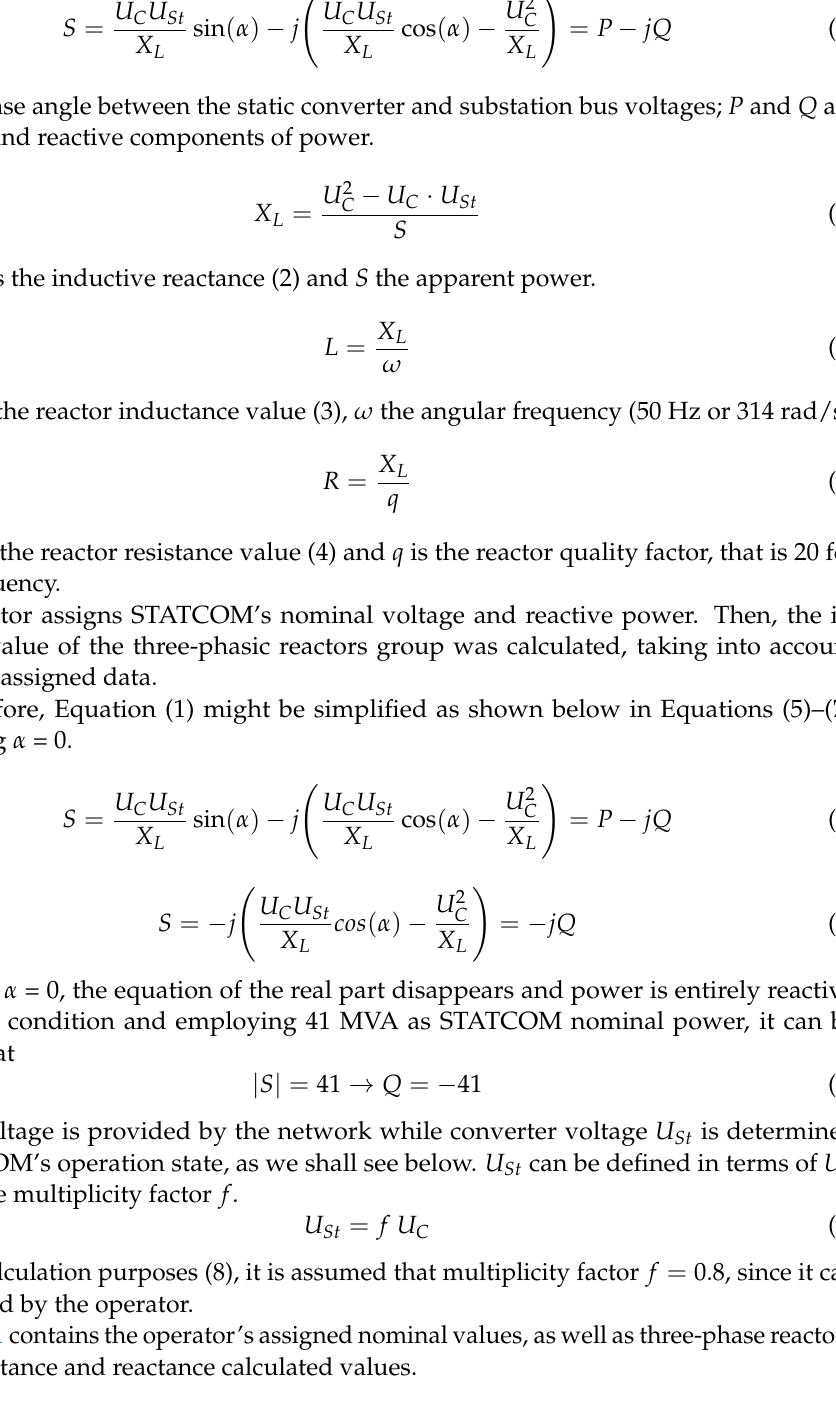
Table 1. Nominal and calculated